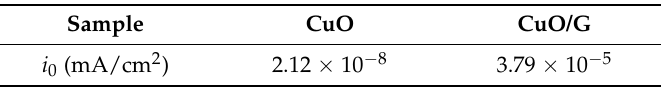
Table 2. Calculated value of i 0 for CuO and